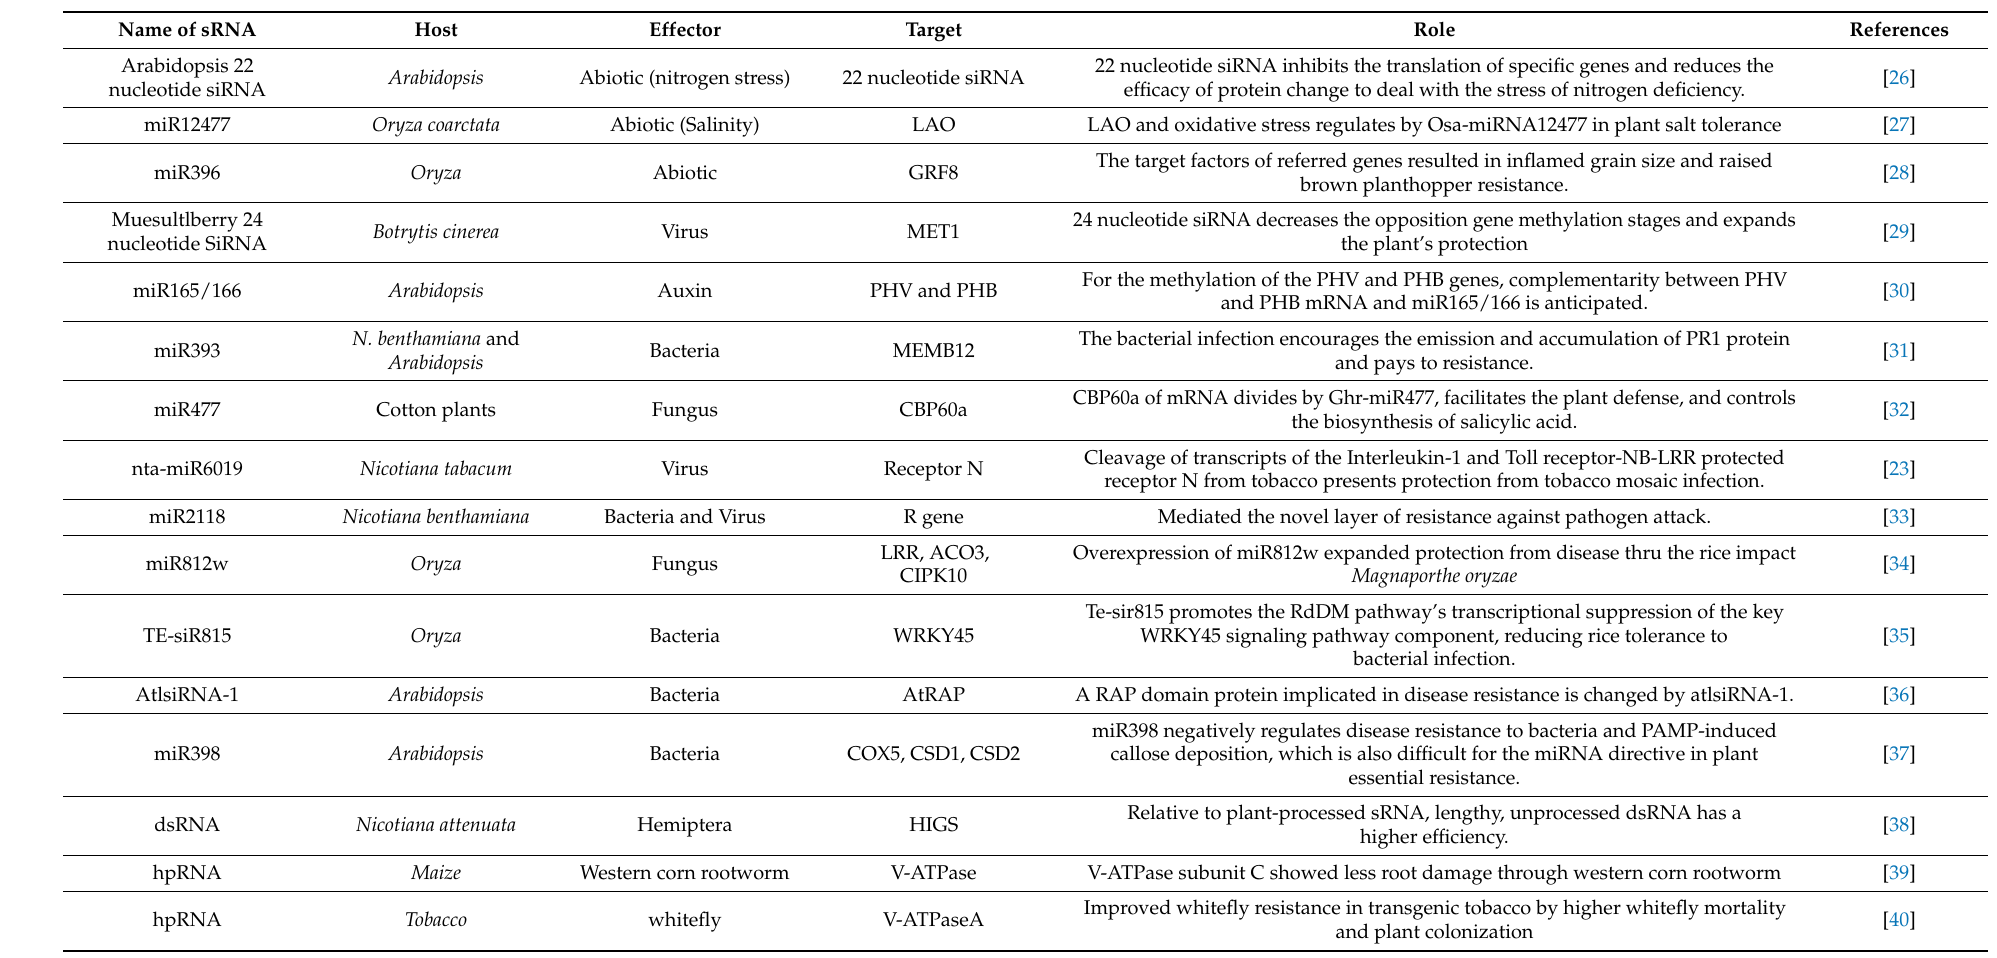
Table 1. sRNA and their roles in plant